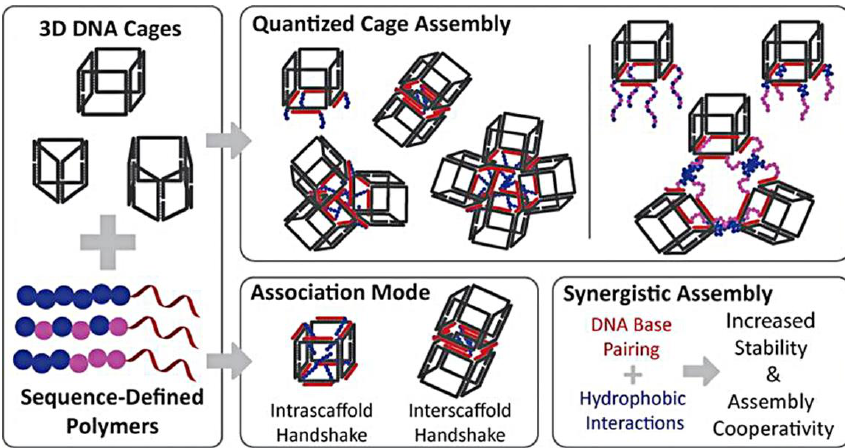
Figure 7. The self-assembly behavior of sequence-defined hydrophobic polymers on different shape of DNA cages. The black frame indicates DNA origami structures, the blue ball stand for long alkyl groups and the red line indicate roil DNA strand. Reproduced with permission from the authors of a previous paper [73]. Copyright 2016 American Chemical Society.